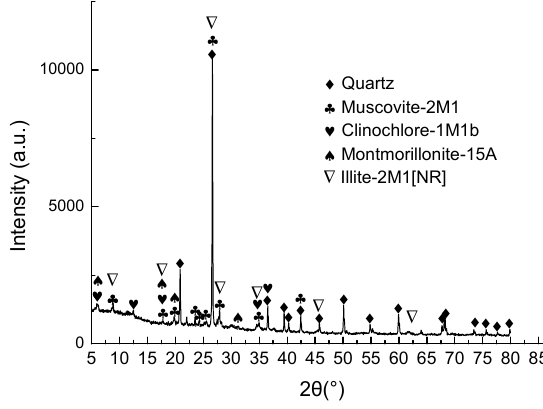
Figure 2. Principal mineral composition of soil.